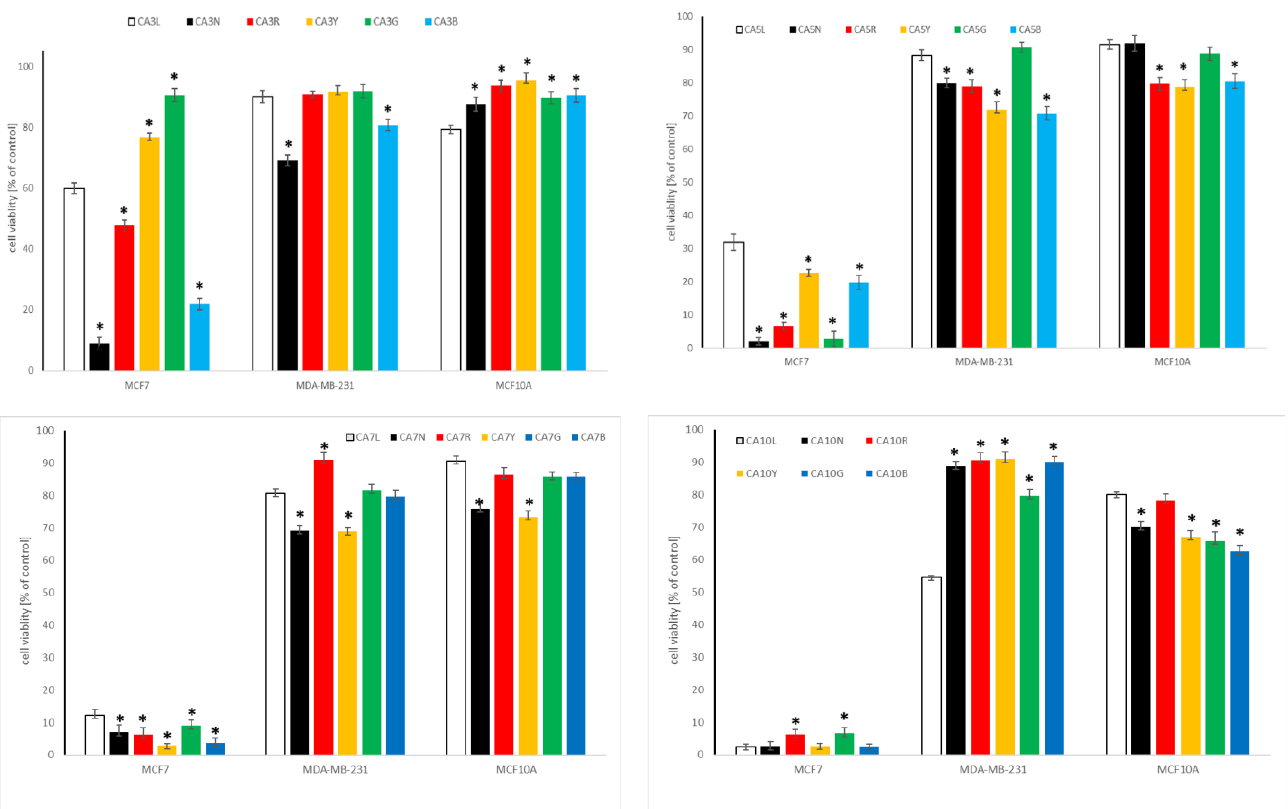
Figure 3. Cytotoxic effect of the extracts of chickpea sprouts (CA) harvested for 3, 5, 7, and 10 days in different LED light conditions: natural (L), darkness (N), red (R), yellow (Y), green (G), blue (B) on breast normal (MCF10A) and cancer (MCF7, MDA-MB-231) cells. Cells were treated with 500 µg/mL of sprout extracts (n = 3) for 24 h. Values are presented as the mean ± SD (standard deviation). Significant differences ( p < 0.05) for each cell lines refer to normal sprouts harvesting procedure and are marked as *.